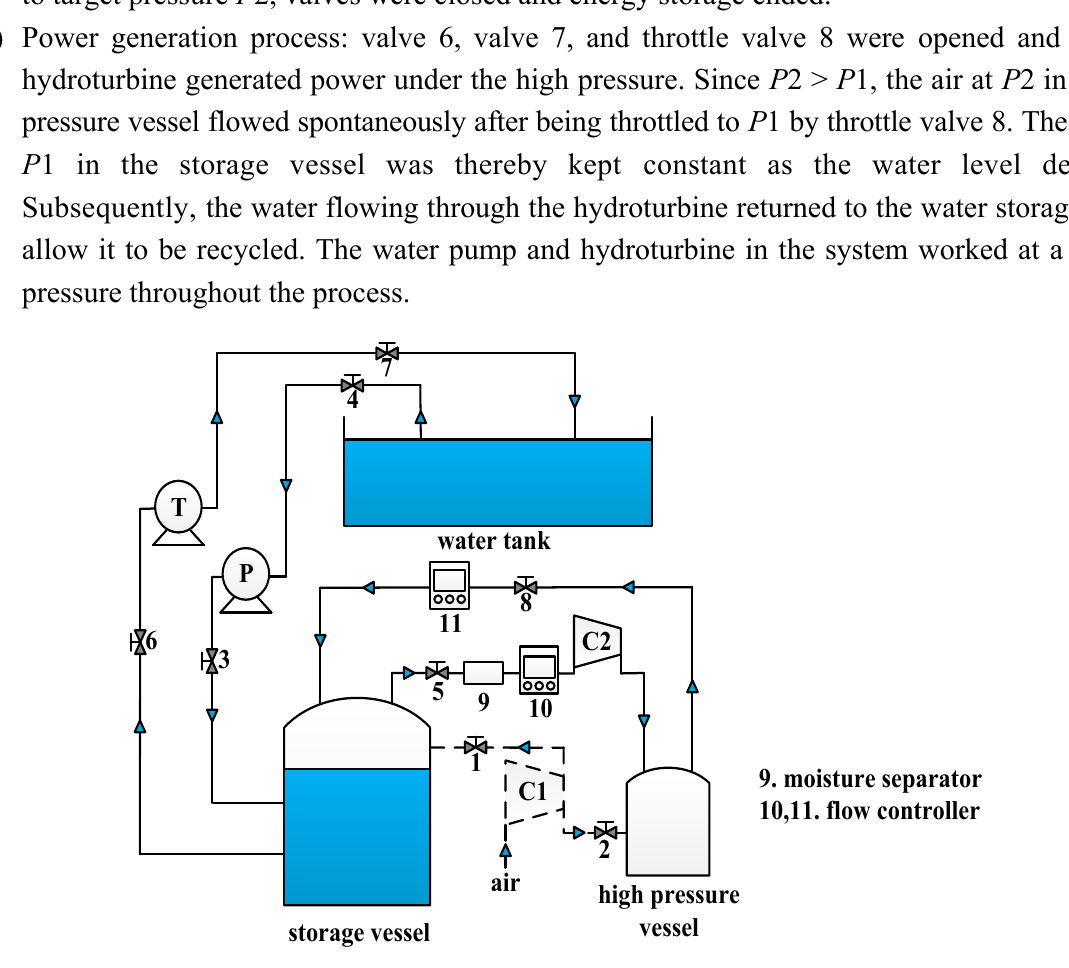
Figure 2. Schematic of the constant-pressure